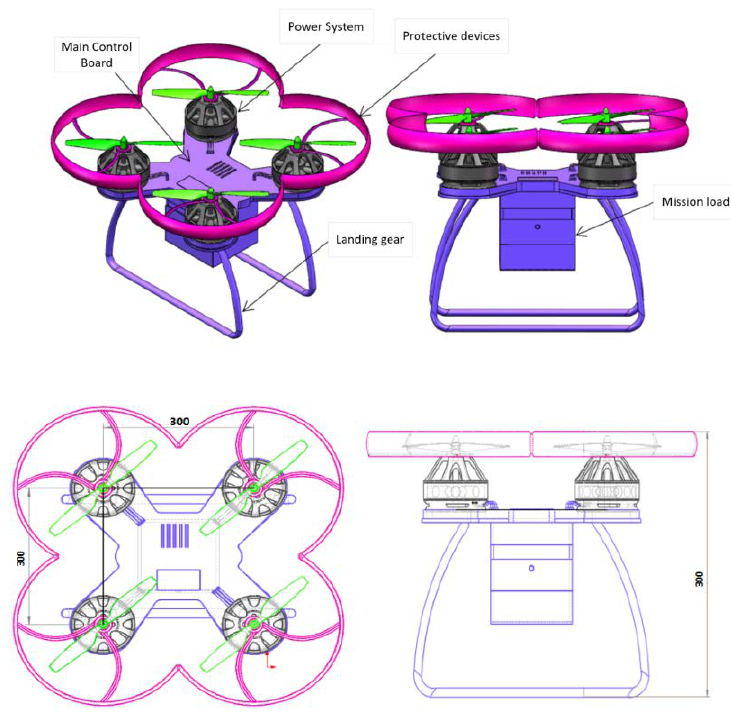
Figure 8. Schematic diagram of rotary wing logistics UAV.